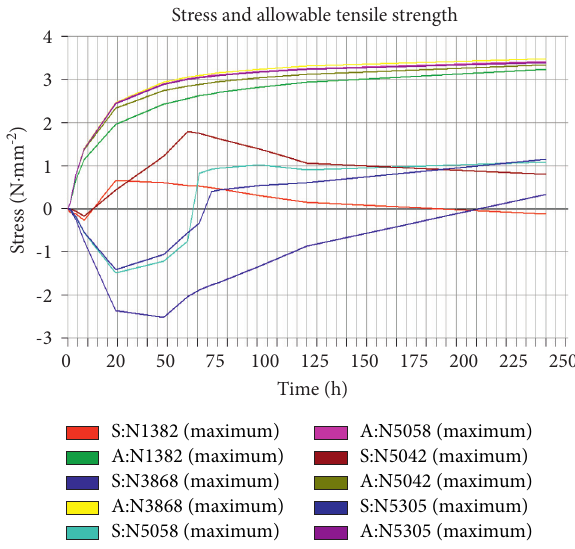
Figure 17: Time-history curve of tower principal tensile